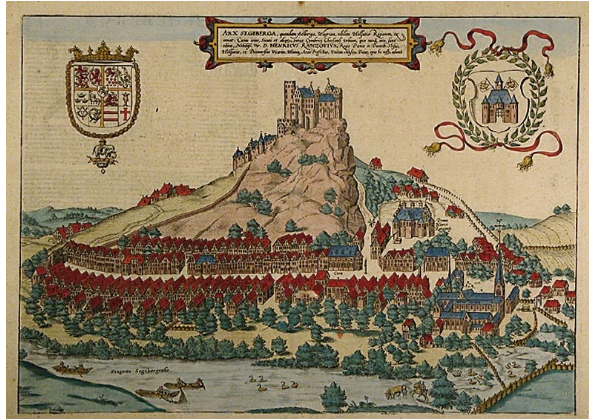
Figure 1. Isometric map of Segeberg including the castle Siegesburg in the year 1588 from Braun-Hogenberg (view from North to